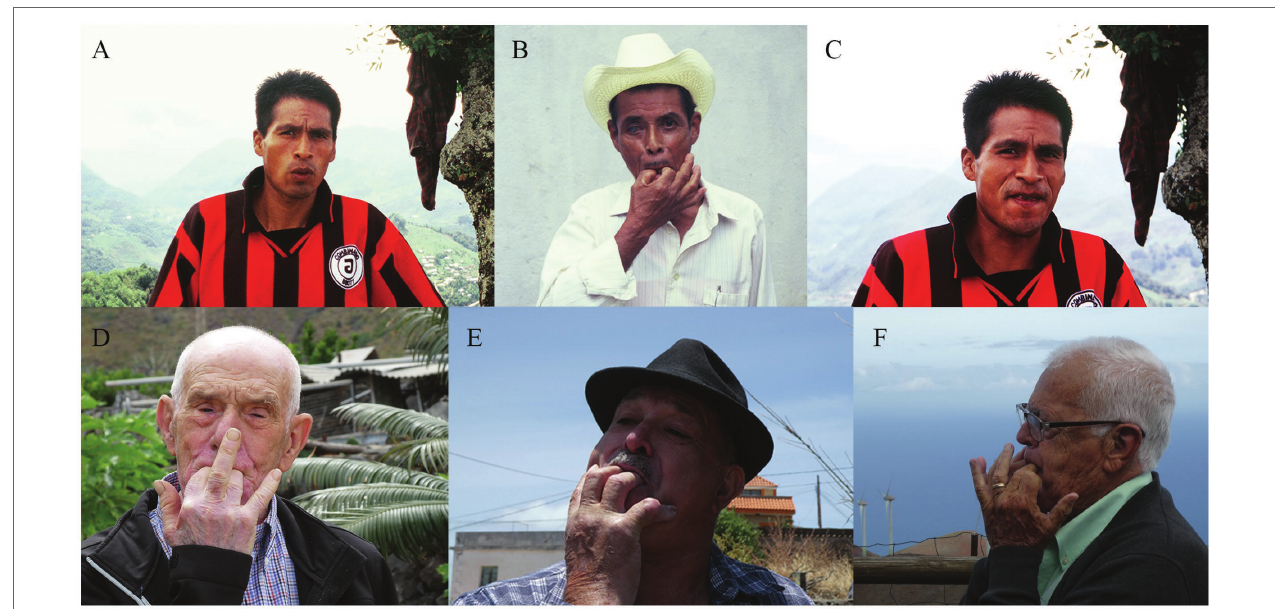
FIGURE 5 | Some examples among the many different whistling techniques used for whistled speech worldwide. (A) . bilabial; (C) . linguo-dental; (B,D-F) , with two fingers in the mouth and forming a V shape at the contact of pressure with the tongue. Photos (A-C) represent three different techniques shown by Mazatec whistlers of Mexico (from Meyer and Diaz, 2017). Photos (D-F) represent three different techniques shown by some of the last traditional whistlers of El Hierro, Canary Island (Spain): the two techniques (D,E) are very characteristic of this island [Photos (D-F) courtesy of Julien Meyer (© Julien Meyer. All Rights